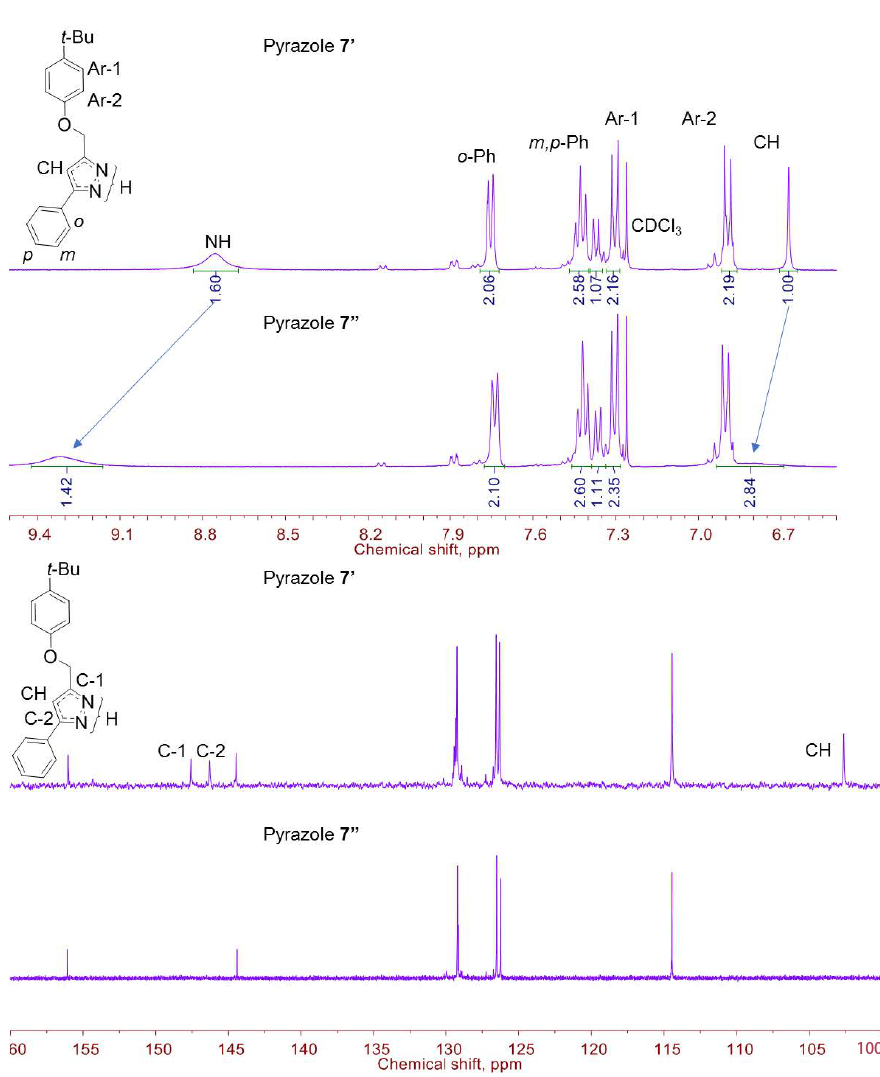
Figure 3. Fragments of 1 Н (6.5 – 9.5 ppm) and 13 С NMR spectra (100 – 160 ppm) of pyrazole 7 .